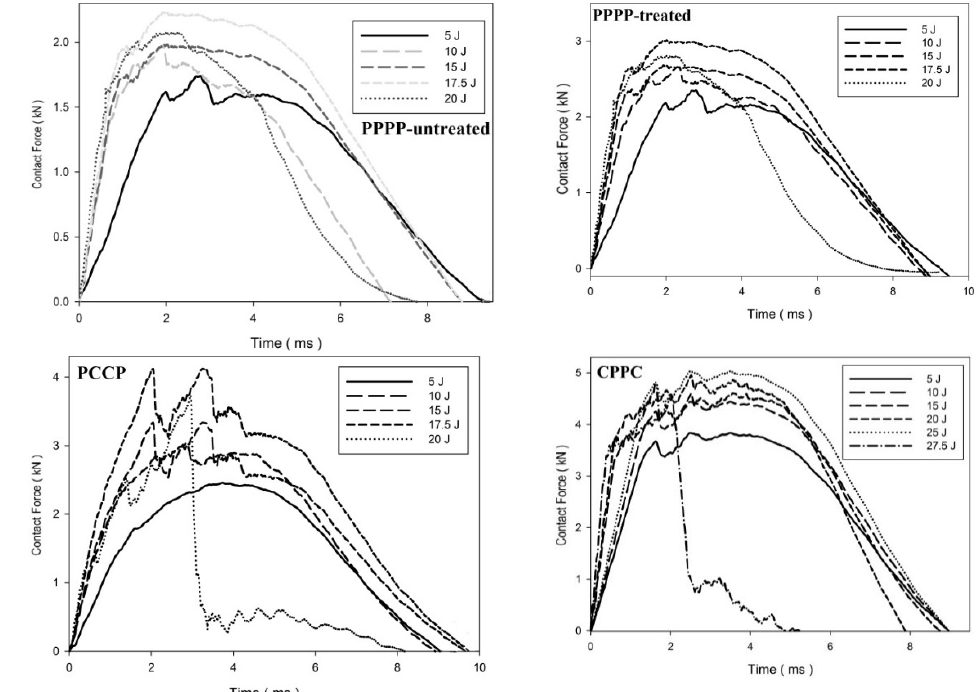
Figure 7. Contact force–time of the hybrid laminates at a ply orientation of [±45°] 8 .